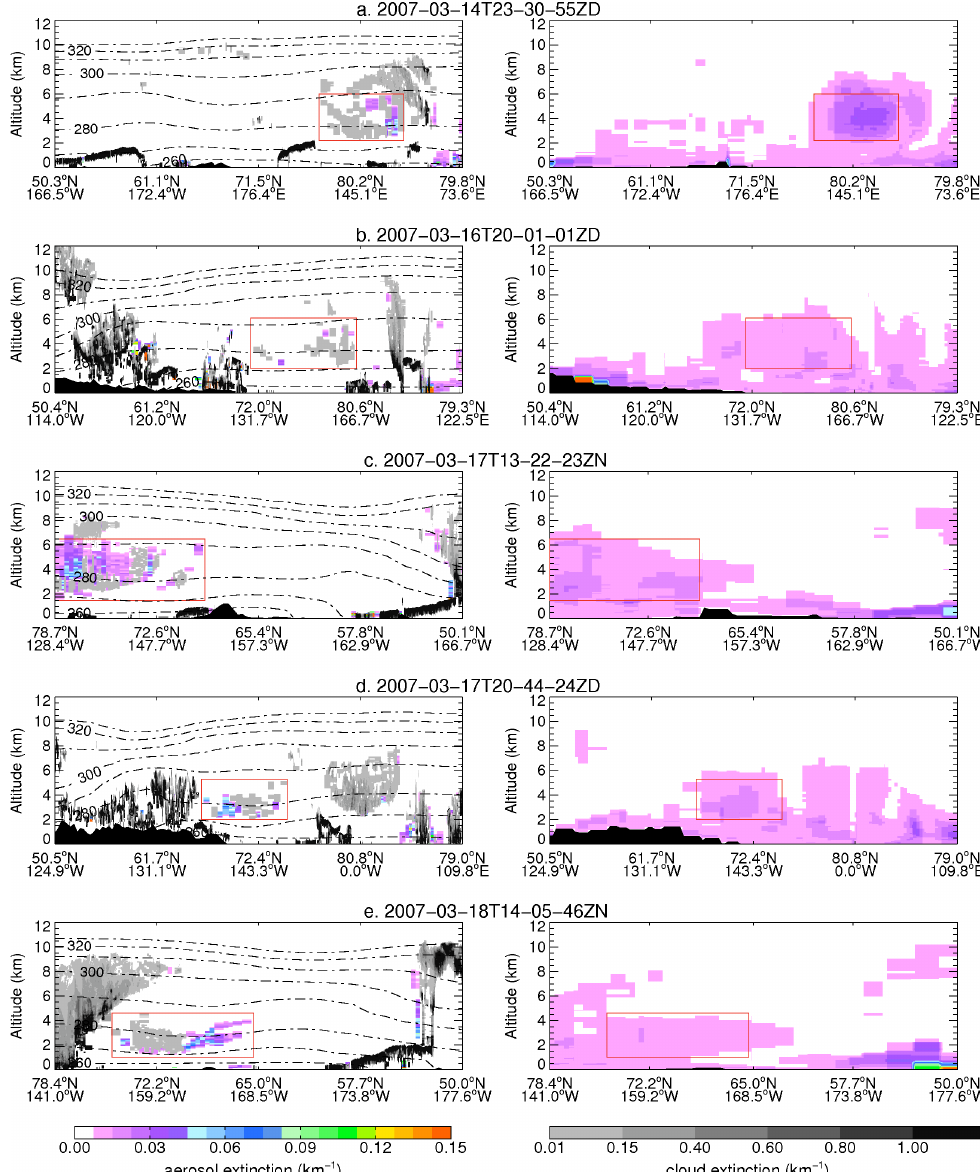
Fig. 8. Same as Fig. 2 for a subset of five major plume cross sections for the 12–19 March 2007 event. The red box delimits the aerosol Figure 8. Same as Figure 2 for a subset of five major plume cross sections for the March 12-19 event. The red box plume cross sections, which are sometimes misclassified as clouds (see delimits the aerosol plume cross sections, which are sometimes misclassified as clouds (see text).